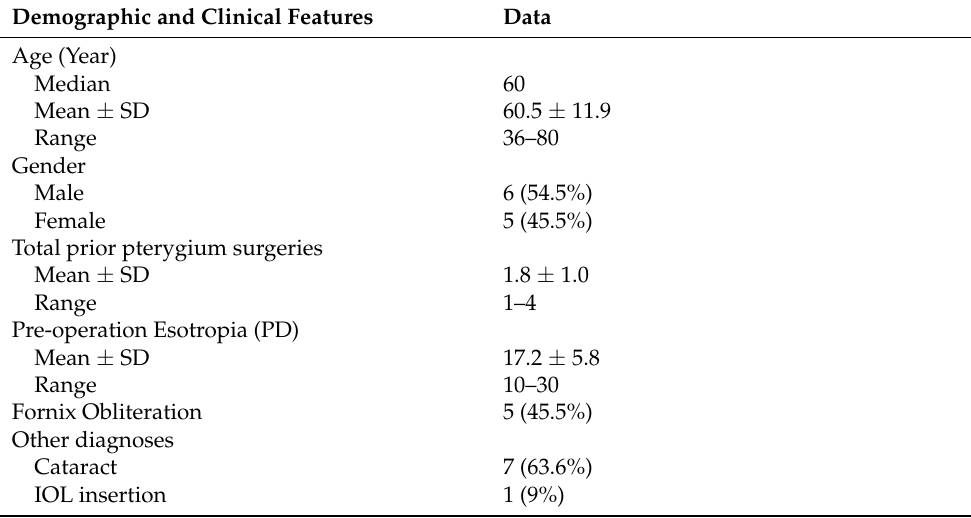
Table 1. Demographic and clinical features of patients with recurrent pterygium and restrictive strabismus who underwent the sandwich transplantation: pre-operation.